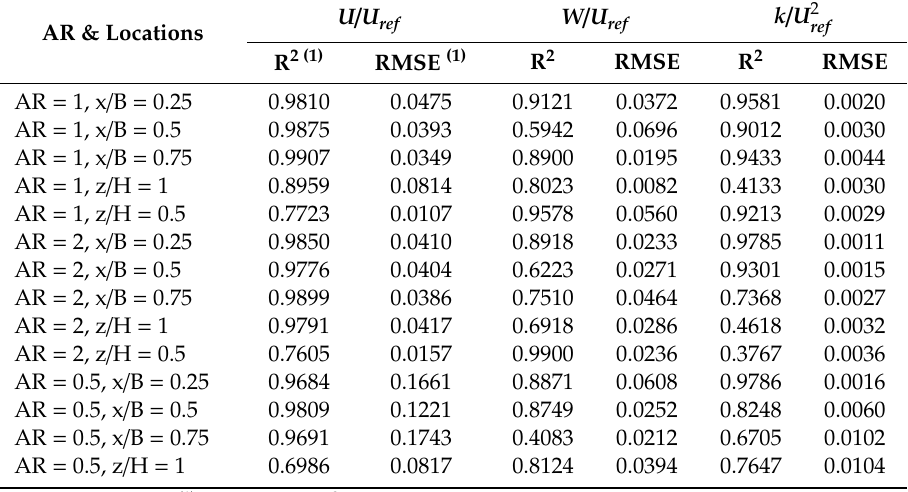
Table 3. Evaluation of flow parameters between the numerical results and experimental data.